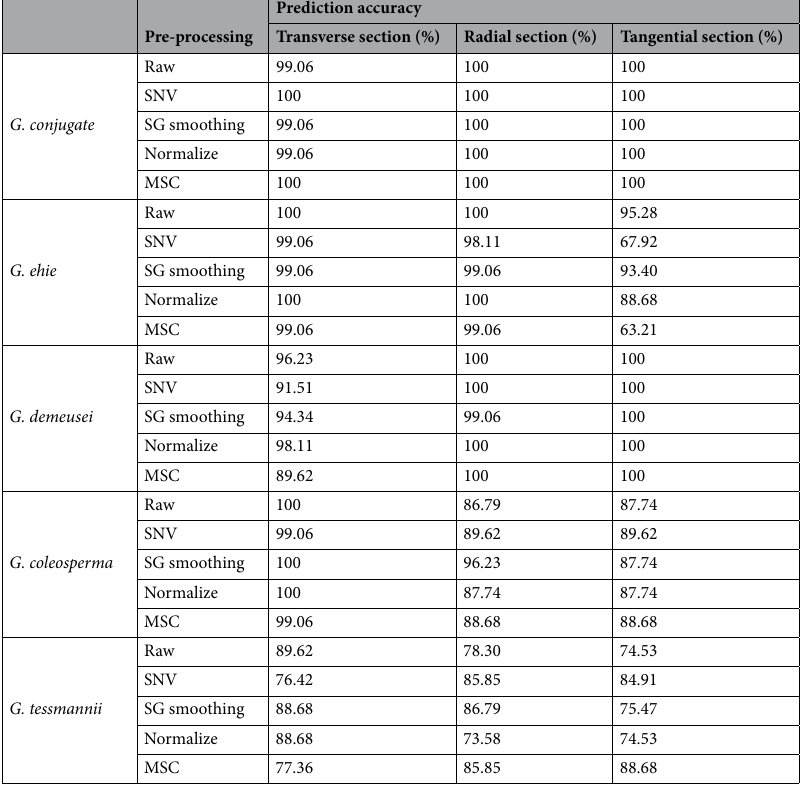
Table 3. Summary of the prediction results of PLS-DA model (based on SPA